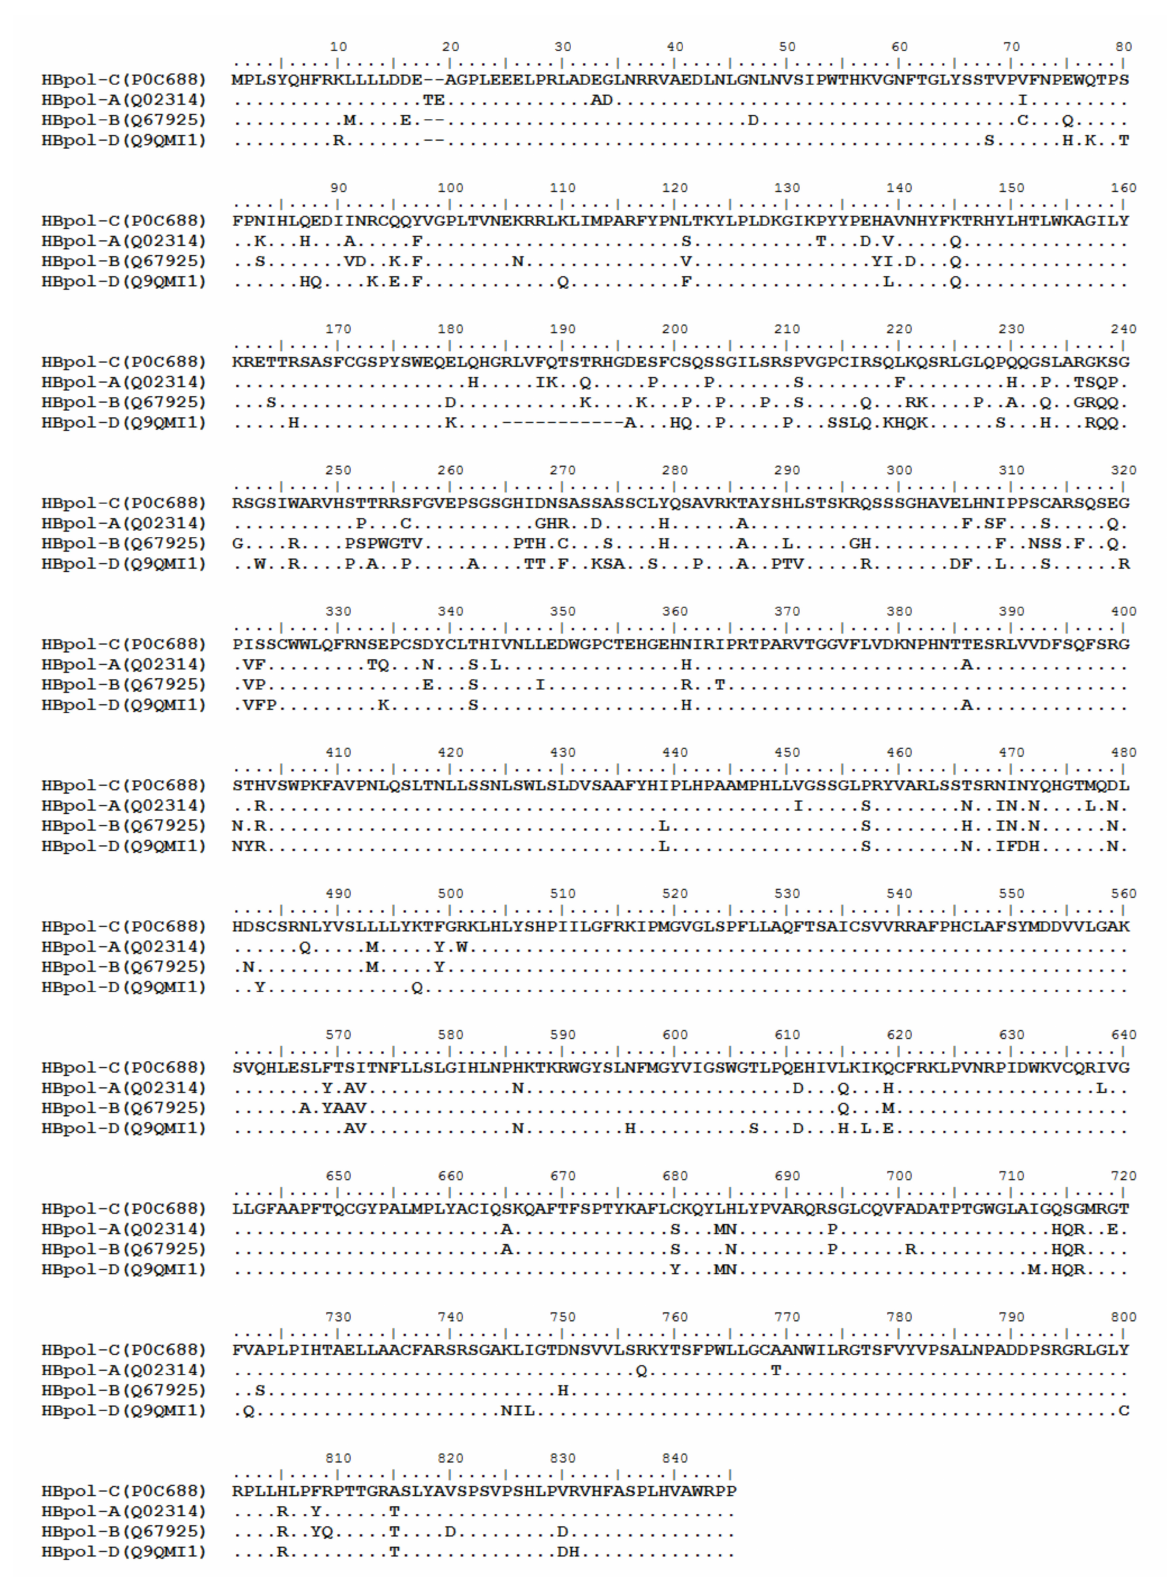
Figure 2. Homologous analysis of HBsAg, HBeAg, HBx and HBpol proteins from HBV C, A, B, and D genotypes. The entire amino acid sequences of each protein from different HBV genotypes were obtained from the UniProt database, aligned and used for in silico prediction of HBV antigen T cell epitopes presented by HLA-A